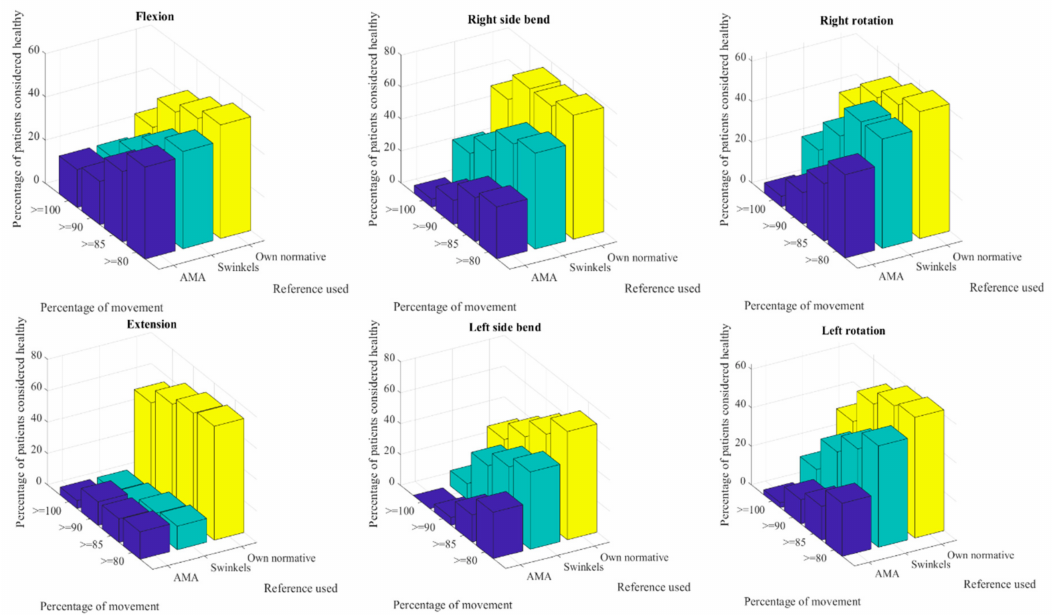
Figure 8. Percentage of cases included as non-pathological with each cut-o ff